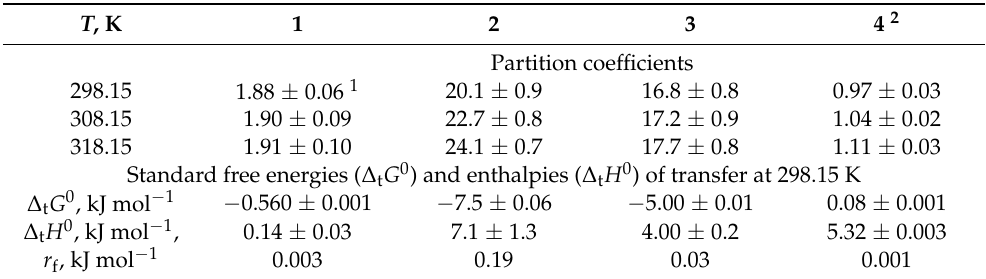
Table 1. Partition coefficients in the 1-octanol/PSB biphasic system and thermodynamics of solute transfer at 298–318